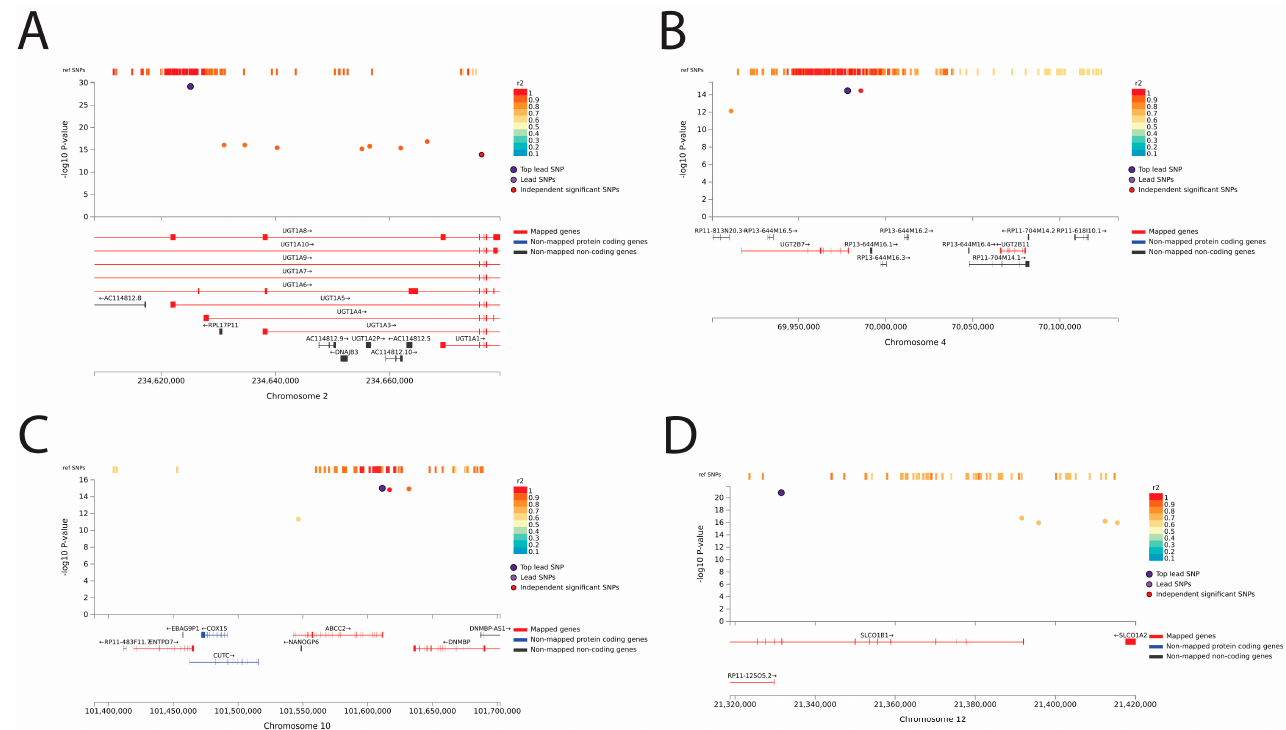
Figure 5. Genomic regions associated with metabolite 1116529, which is associated with four distinct loci. ( A ) Genomic locus 15. ( B ) Genomic locus 19. ( C ) Genomic locus 48. ( D ) Genomic locus 54. In all panels of the figure, the SNPs associated with the levels of circulating metabolite 1116529 are represented by points, where purple points refer to the top lead SNP, and other SNPs are represented by points colored by their r2 value. The r2 value, which represents phenotypic variation, is high in these regions and reference SNPs that have previously been analyzed. The nearest mapped genes are shown below each plot.